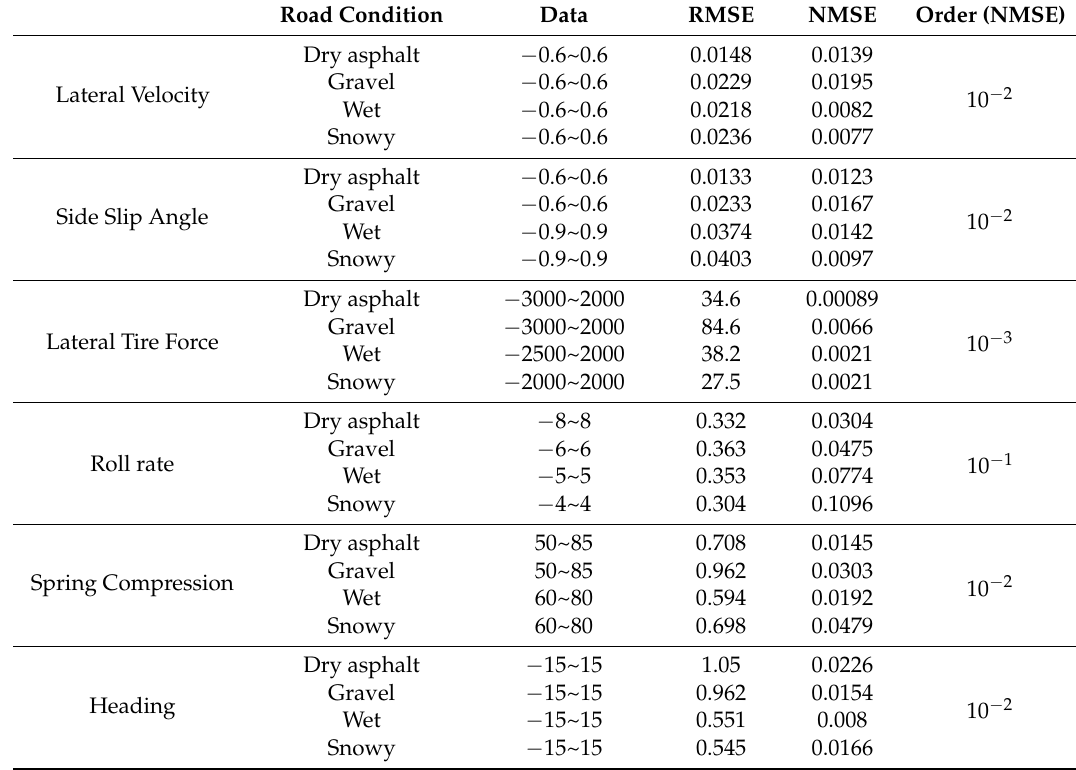
Table 4. Range of data, RMSE and NMSE in each case.